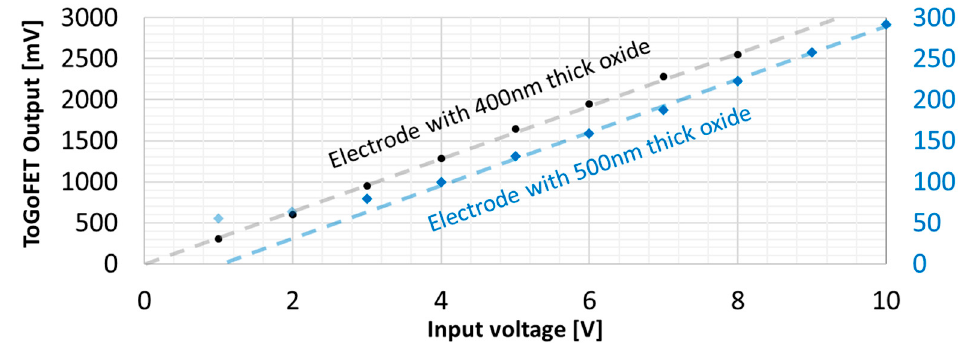
Figure 8. Magnitudes of ToGoFET signals from buried electrodes by input voltage. Noise-dominated data are shown in a light color.